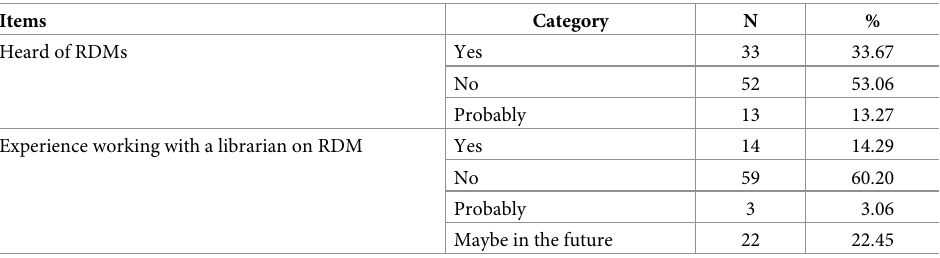
Table 2. Knowledge of available